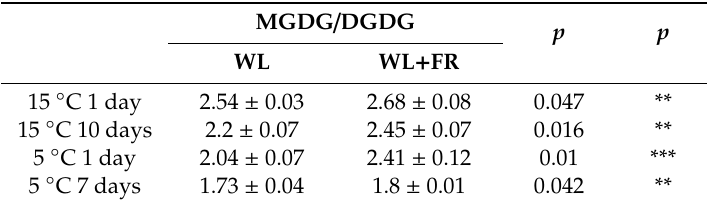
Table 2. The MGDG / DGDG lipid ratios in barley leaves grown at 15 ◦ C for 1 and 10 days and in leaves grown at 5 ◦ C for 1 and 7 days under WL and WL +